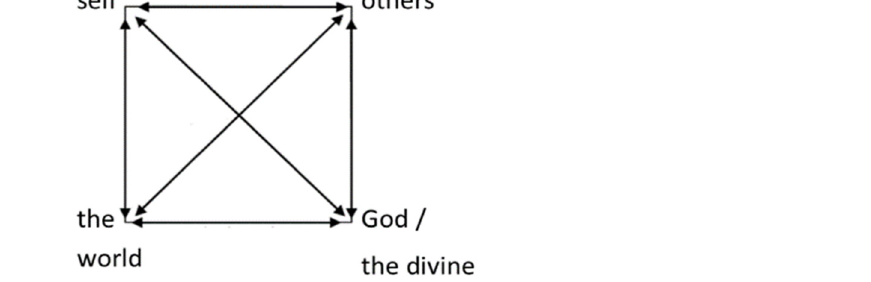
Figure 1. The existential quadrant: dynamic interactions between self, other, world and God/the